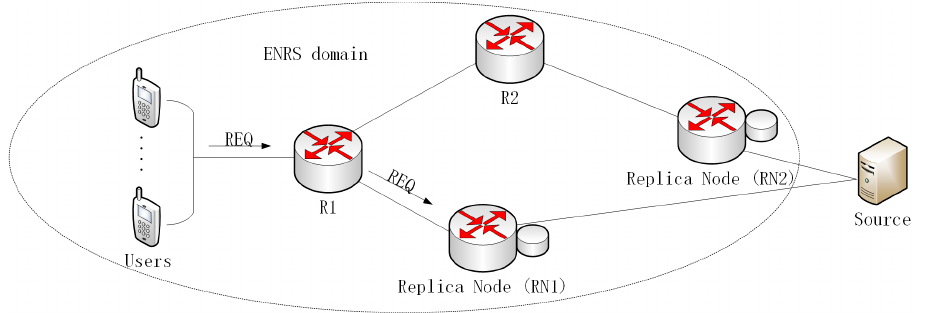
Figure 3. Schematic diagram of replica selection.